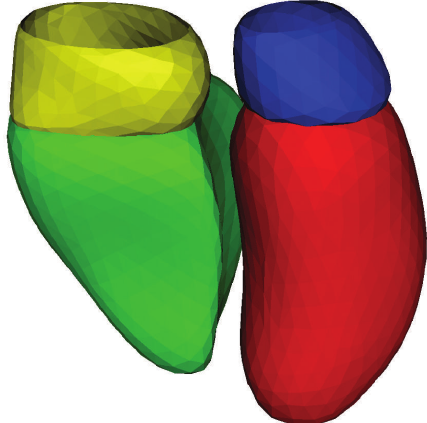
Figure 8: Endocardium surface meshes generated by the proposed method for the left ventricle (red), right ventricle (green), left atrium (blue), and right atrium (yellow).